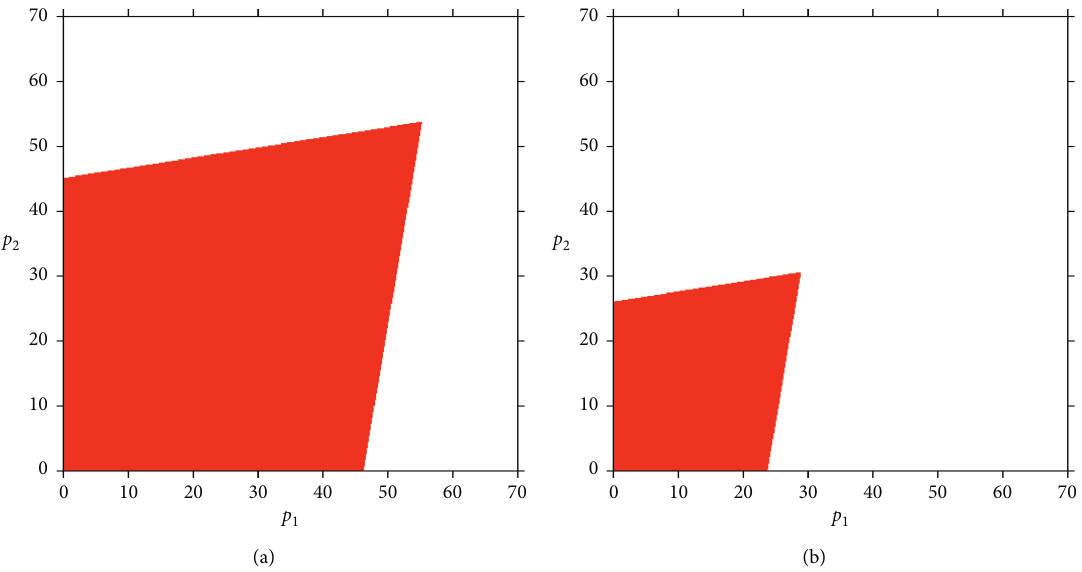
Figure 7: Basins of attraction of dynamic system (15) with δ